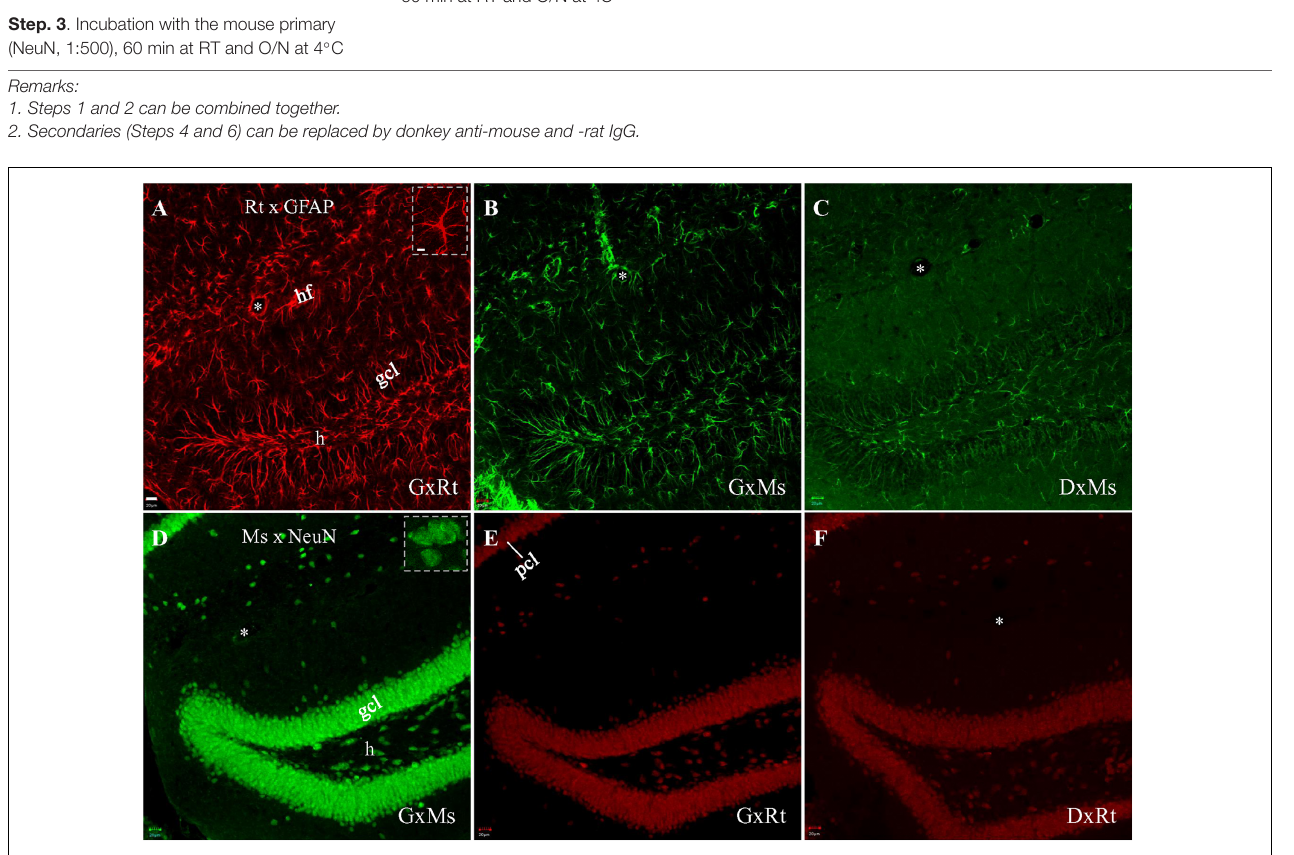
Frontiers in Neuroscience |